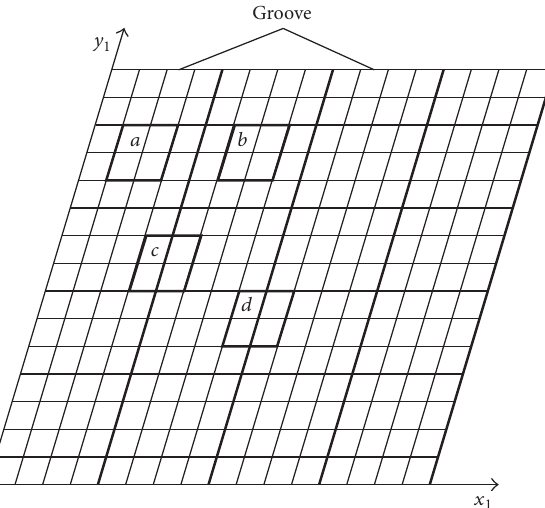
Figure 20: Schematic diagram of the expanded grids of the bearing. nodes on each grid must be mapped to the corresponding grid cell. To transfer displacements, the nodes of the fluid coupling surface must be mapped to the solid coupling cell.